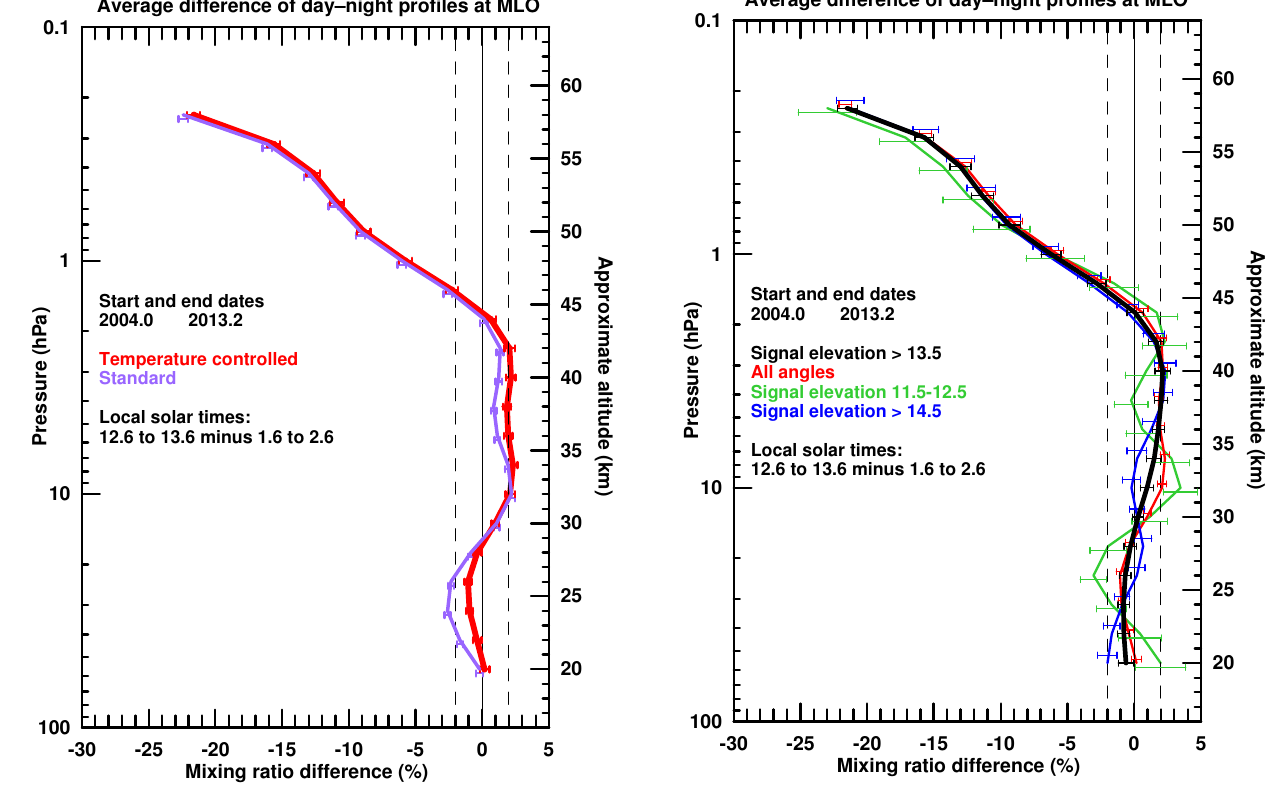
Figure 1. MWR measurements of daytime (12:36 to 13:36LST) minus nighttime (01:36 to 02:36LST) ozone differences at Mauna Loa from data recorded within 1.2 ◦ C of the room thermostat setting (red) and standard data without this restriction (violet), as described in the text. Individual measurements were averaged over the period January 2004 to March 2013 and combined and normalized as de- scribed in Sect. 2.1 to make this figure. The error bars are set equal to 2 × rms × n − 0 . 5 , where n is the number of individual measure- ments in the average for each data point and rms is the root-mean- square of the individual values in that set of measurements. The ver- tical positions of the error bars have been offset slightly from their nominal pressure values to display the errors more clearly. Vertical dotted lines at ± 2% are provided as a guide to the eye.